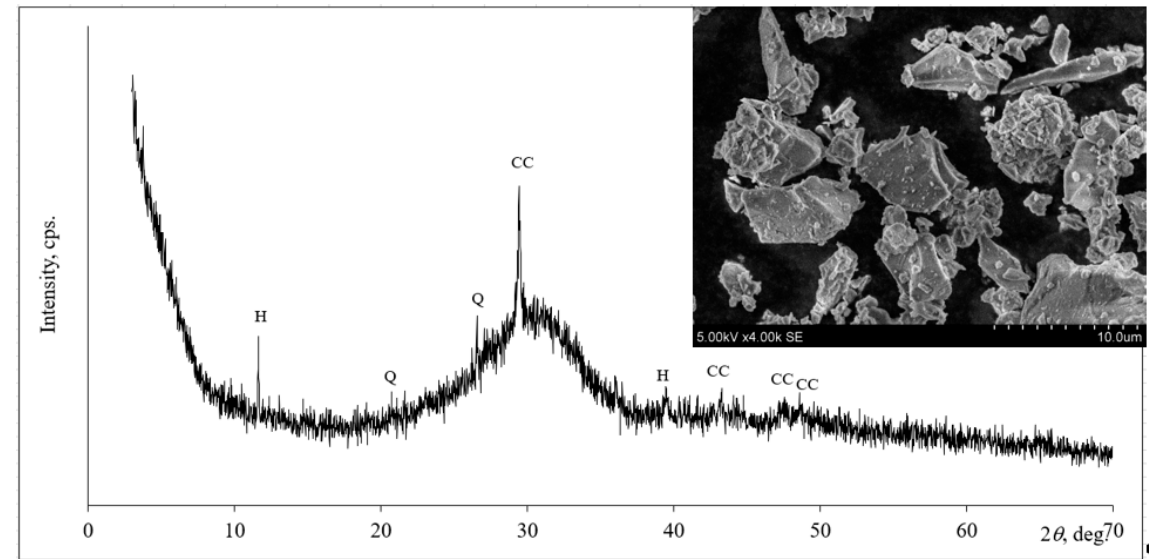
Figure 2. The mineral composition (X-ray diffraction patterns) and microstructure of slag. Notes: CC—calcium carbonate, CaCO 3 (72–1651); Q—quartz, SiO 2 (83–539); H—hydrotalcite, Mg 6 Al 2 CO 3 (OH) 16 ·4H 2 O (14–191).